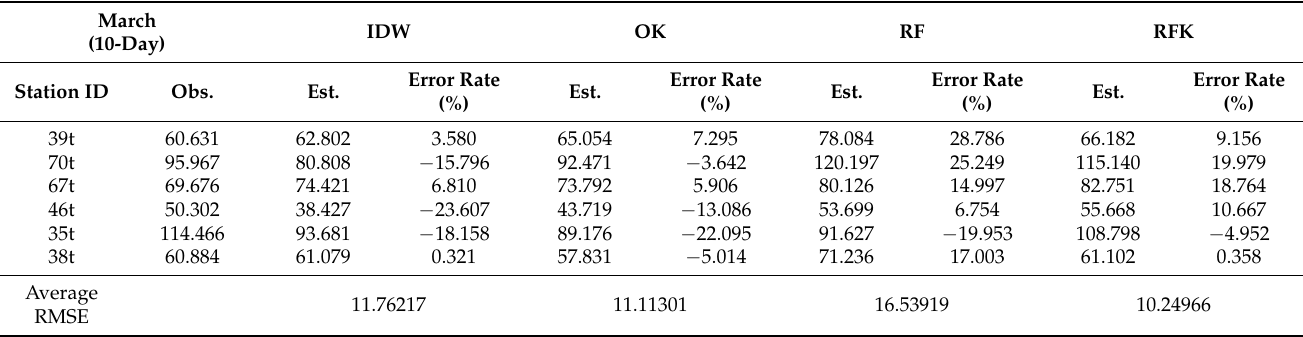
Table 4. Test station-based comparison between observations and estimates from interpolation models with observed concentration over 50 µ g/m 3 from a 10-day dataset in March.